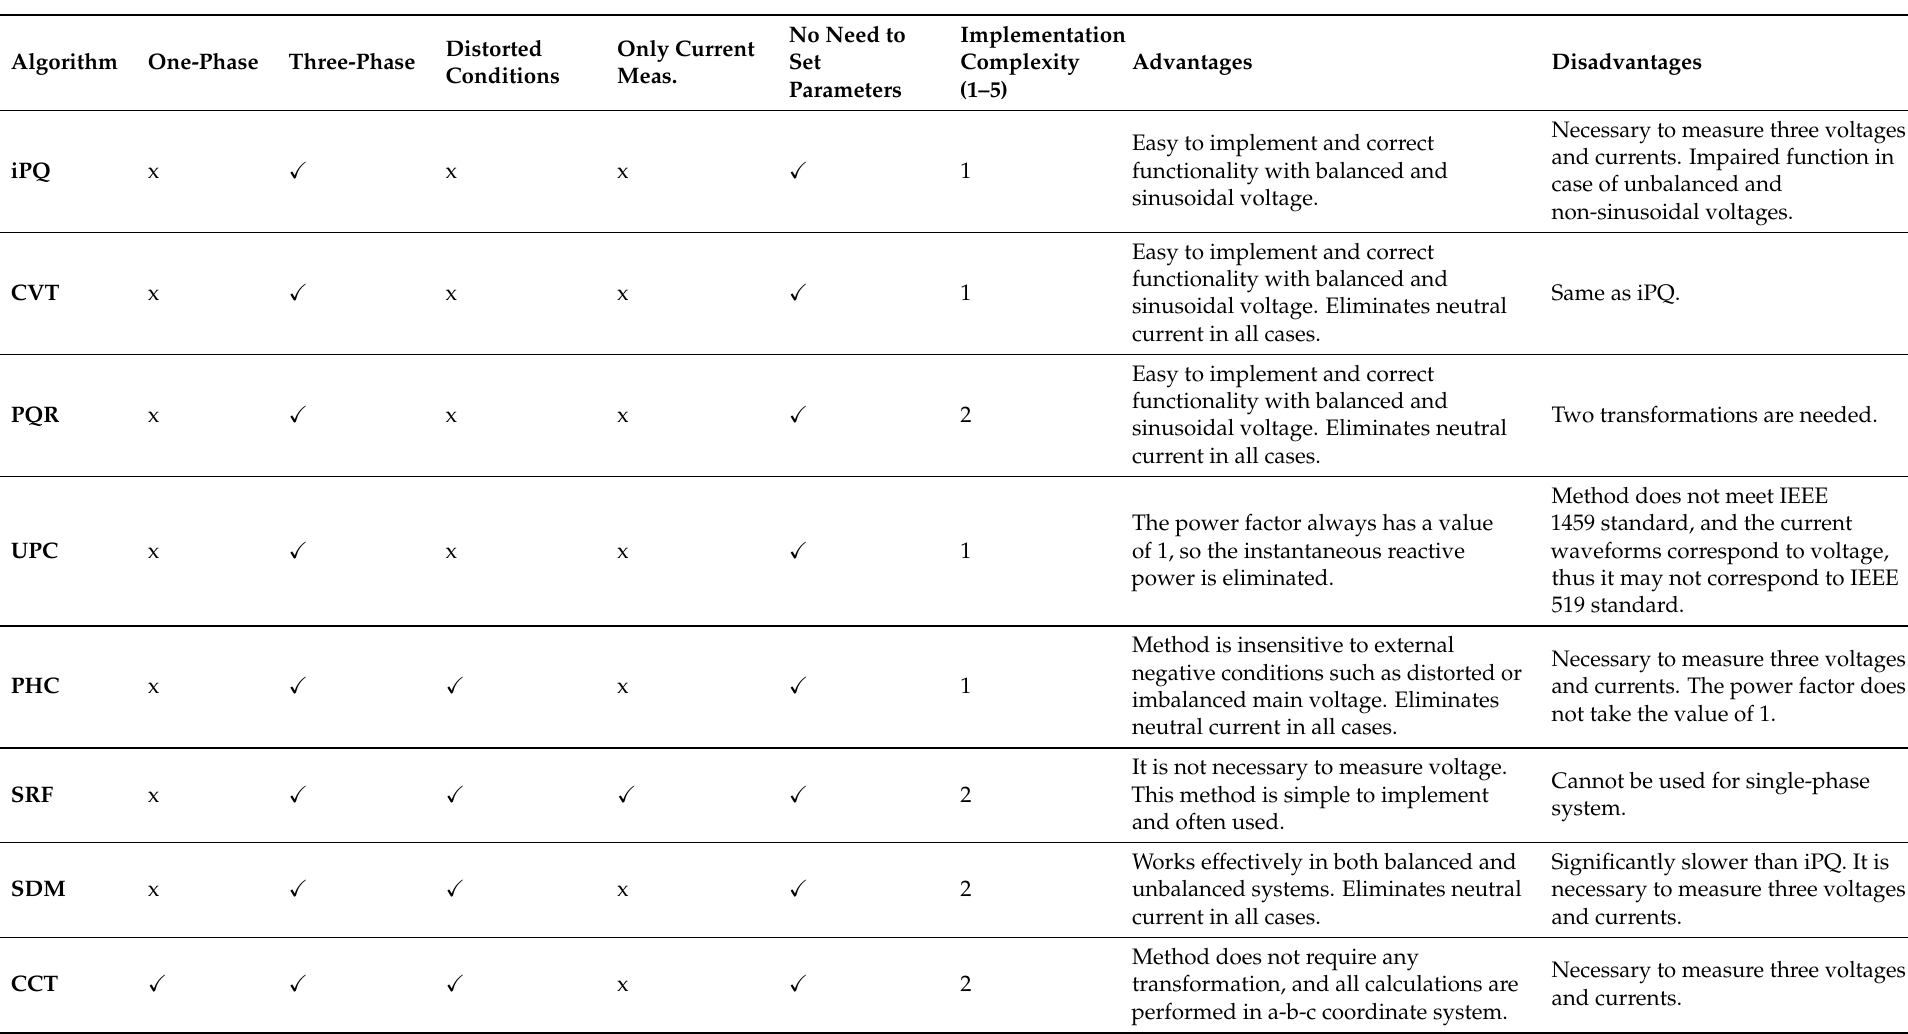
Table 1. Summary of Harmonic Extraction